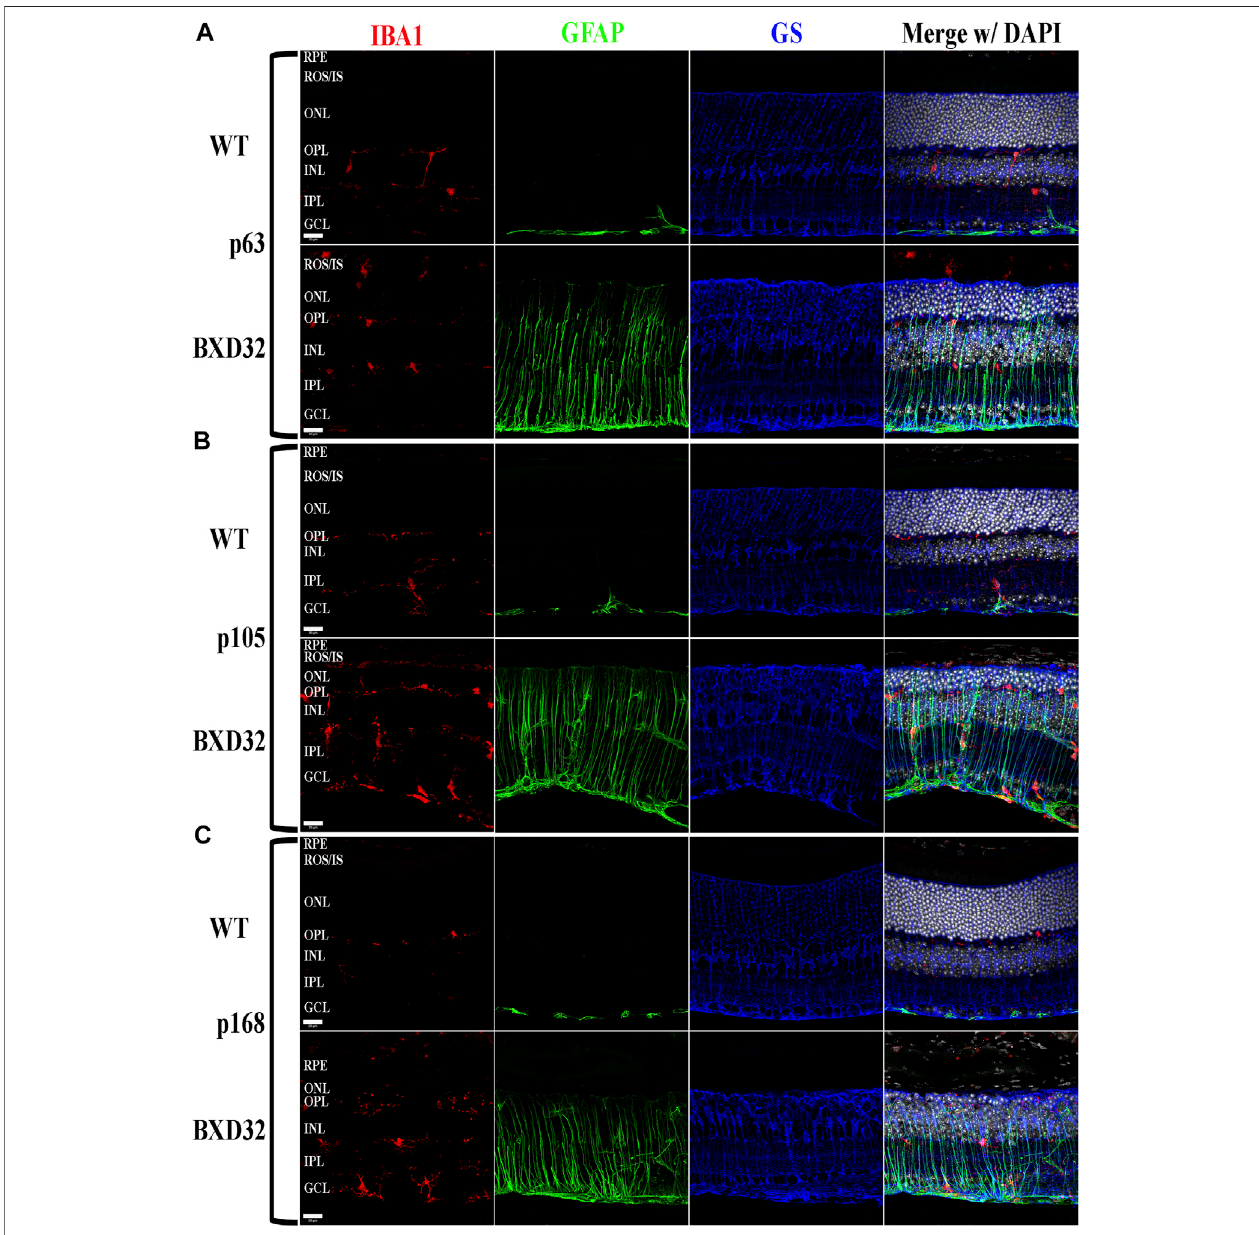
FIGURE 4 | BXD32 mouse retinas have advanced glial hypertrophy and an increased presence of monocytes in the outer retina. WT and BXD32 retinal sections were immunolabeled for glial cells using IBA1 (red), GFAP (green), and GS (blue). Beginning at the earliest timepoint examined p63 (A) , BXD32 retinas exhibit dramatic upregulation of GFAP and a larger number of monocytes, presumably microglia, both in the outer retina and the retina as a whole. By p105 (B) , no decrease in GFAP is observed and monocyte numbers are even higher than at p63. At p168 (C) , the outer retina is mostly degenerated and while monocyte numbers are lesser from p105, GFAP is still upregulated, indicating continued retinal stress. GS levels remained relatively similar amongst WT mice and BXD32 mice, with occasional variations with age. Nuclei stained with DAPI (white/grey). RPE, retinal pigment epithelium; ROS/IS, rod outer segments/inner segments; ONL, outer nuclear layer; OPL, outer plexiform layer; INL, inner nuclear layer; IPL, inner plexiform layer; GCL, ganglion cell layer. Scale bars = 20 μ